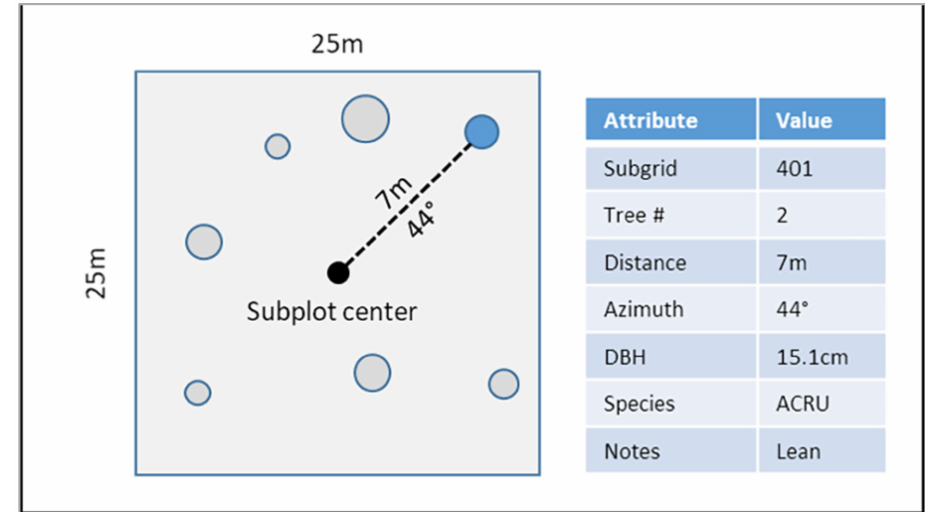
Figure 2. Visualization of manual data collection process and key data points.